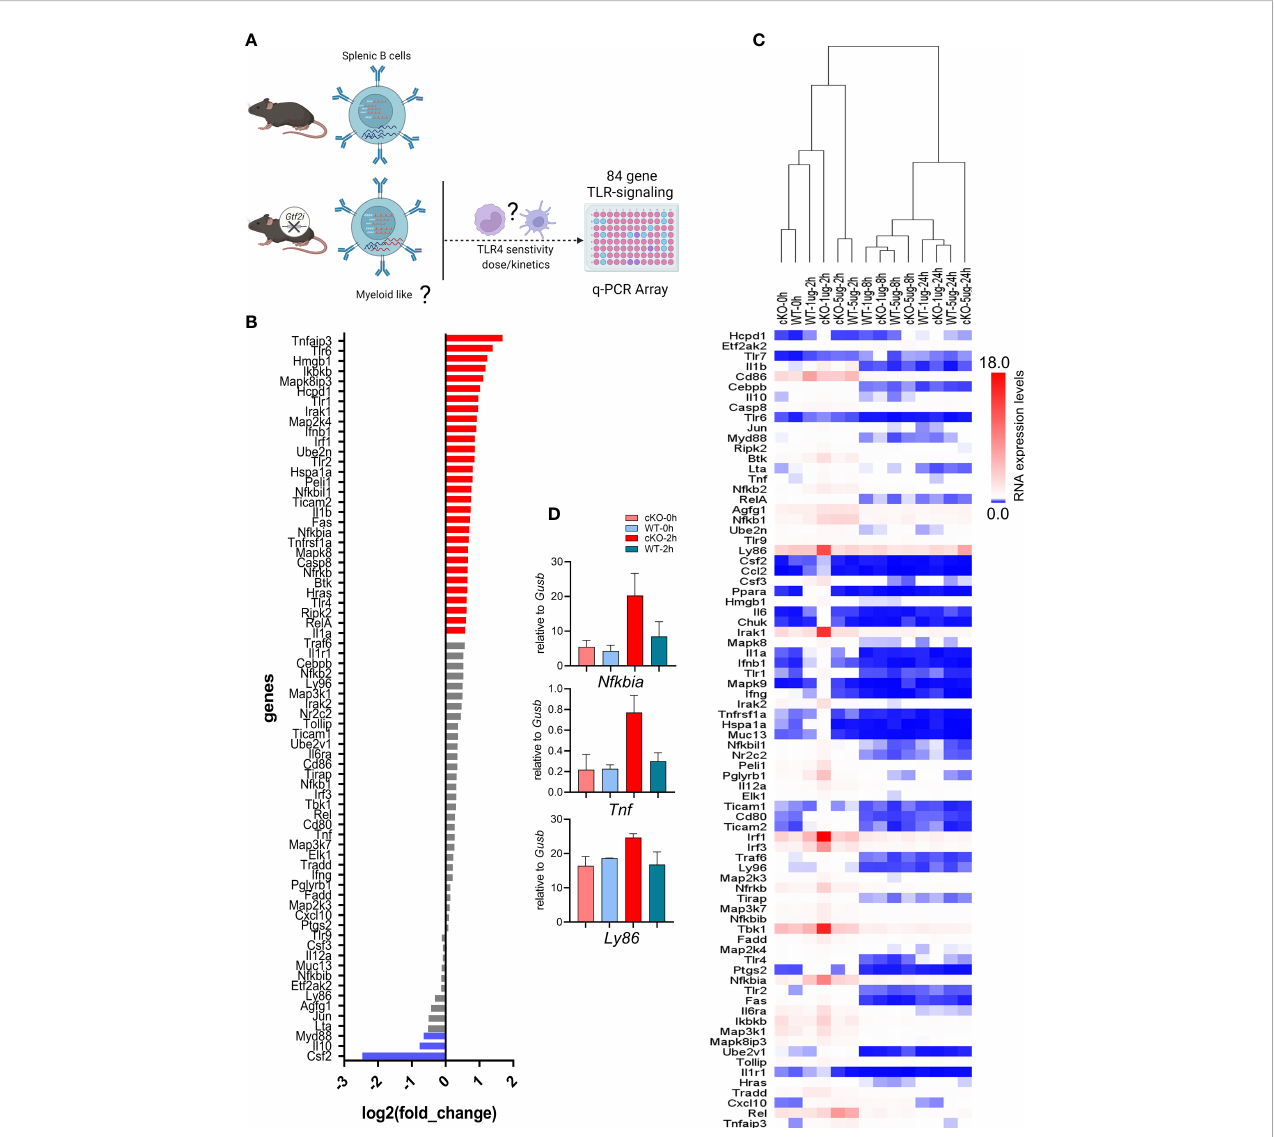
FIGURE 7 Transcriptome of LPS responsiveness splenic B cells upon Gtf2i ablation. (A) Scheme representing (created using BioRender.com) the identi fi ed differences of transcriptome and open chromatin in B cells upon Gtf2i ablation. These differences indicate cKO B cells to possess myeloid like features, which are tested for TLR4 sensitivity by activation with LPS (5 and 1µg/ml) at early, mid and late time points (2, 8 and 24 hours) using TLR-signaling array. (B) Basal level expression of genes downstream of TLR-signaling in WT and cKO B cells. Red bars represent 30 genes highly expressed in cKO and blue are highly expressed in WT by at least 1.5-folds (n=4). (C) Heatmap representing the RNA expression levels of 84 TLR-responsive genes from LPS high (5µg/ml) and low (1µg/ml) dose at early (2h), mid (8h) and late (24h) time points (n=3). Relative expression of target genes was calculated to geometric mean of Ct values of Gusb and Hsp90a . (D) Nfkbia, Tnf and Ly86 mRNA levels were determined from the Mouse Toll-Like Receptor Signaling Pathway